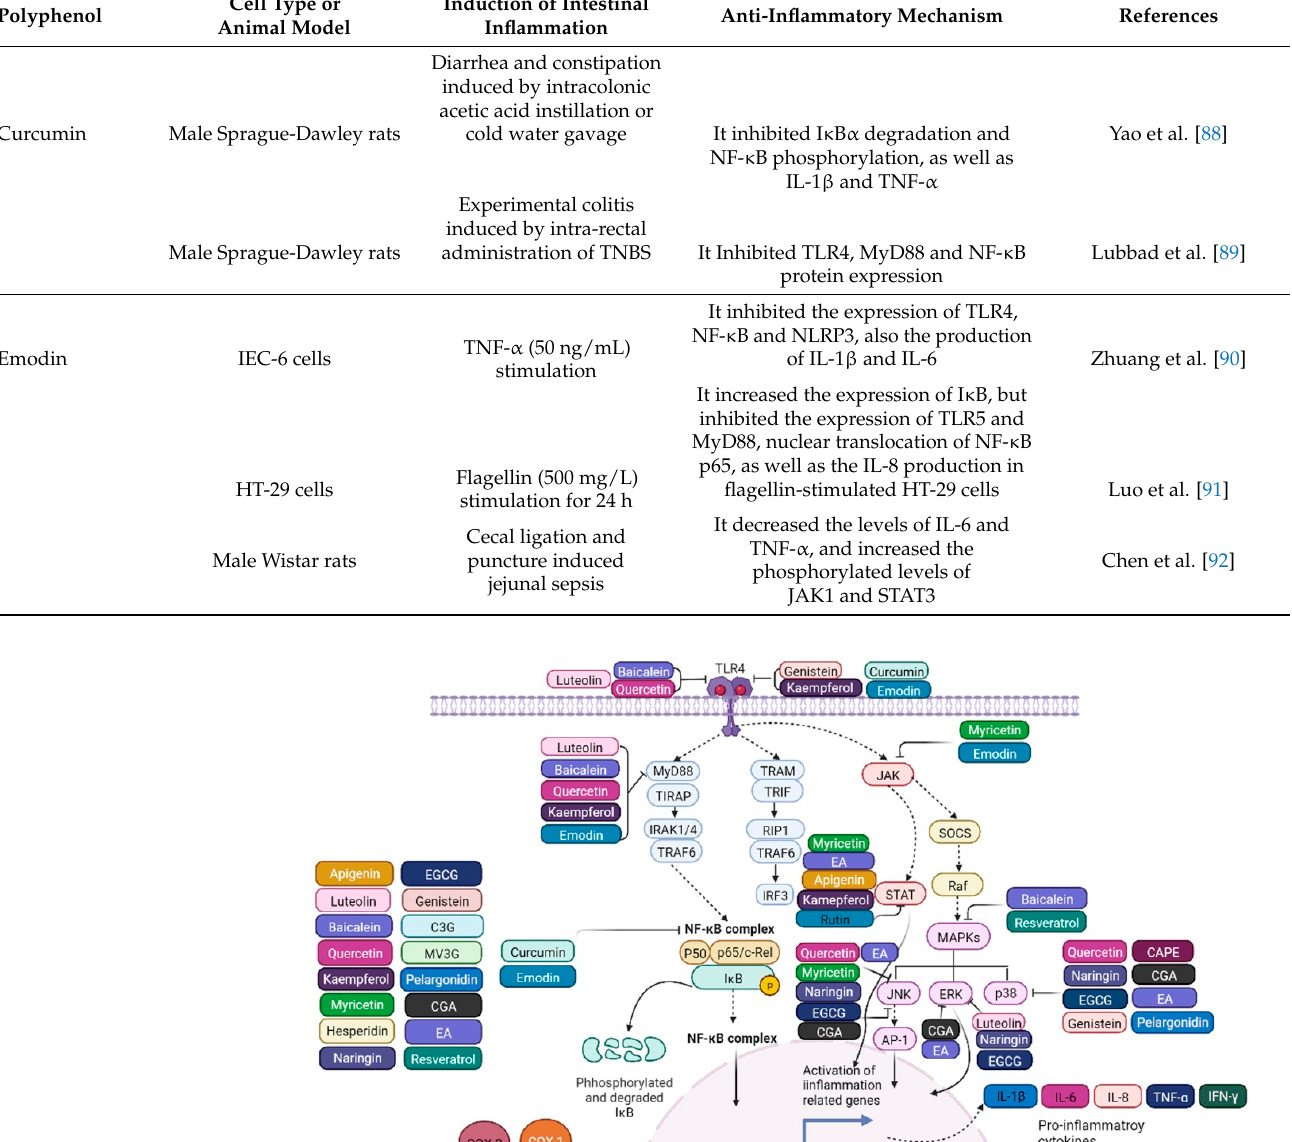
Figure 2. The intestinal anti-inflammatory mediated effects of polyphenols along the TLR4 signal- ing pathway. EGCG, epigallocatechin-3-gallate; C3G, cyanidin-3-glucoside; MV3G, malvidin